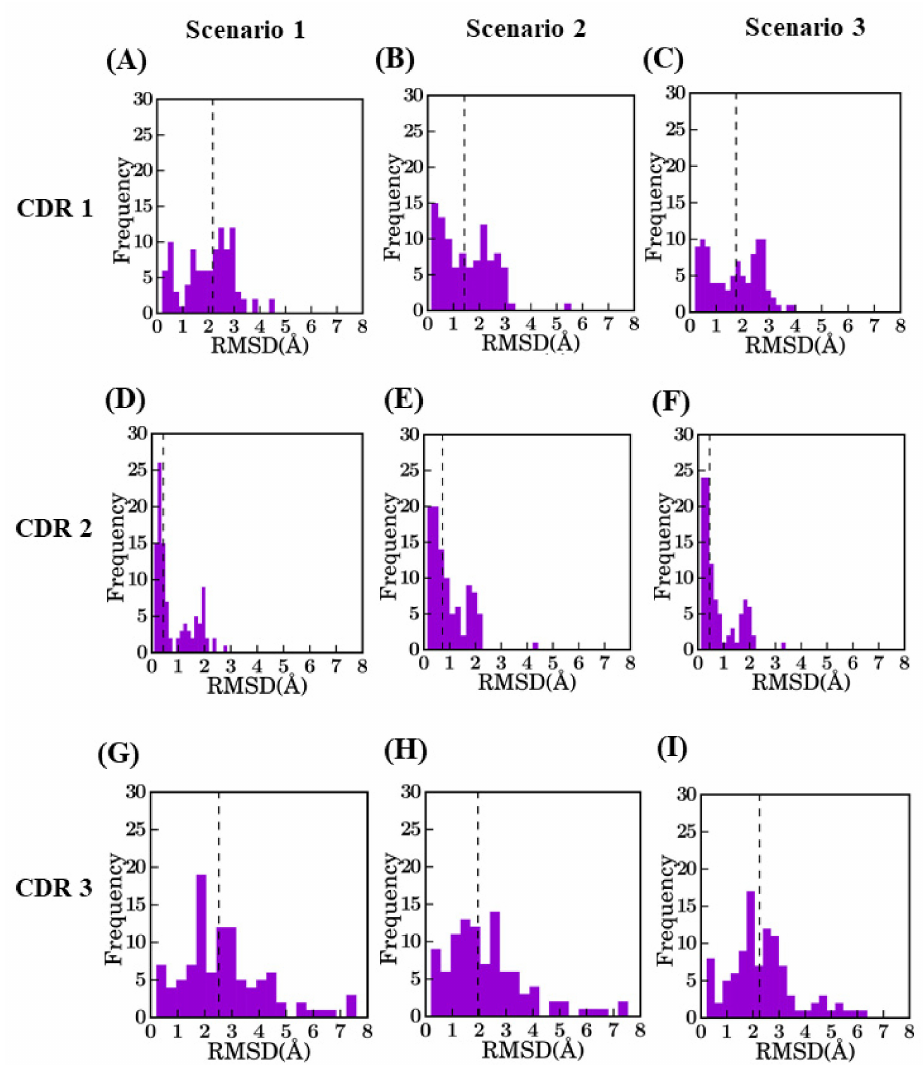
Figure 4. Distribution of RMSD values for different CDRs between selected model and crystal struc- ture. CDR1 for ( A ) bestSeqIdTemp (median value of 2.2 Å), ( B ) bestStructTemp (1.4 Å), and ( C ) 3bestSe- qIdTemp (1.8 Å), CDR2 for ( D ) bestSeqIdTemp (0.4 Å), ( E ) bestStructTemp (0.7 Å), and ( F ) 3bestSeqIdTemp (0.5 Å), CDR3 for ( G ) bestSeqIdTemp (2.5 Å), ( H ) bestStructTemp (1.9 Å), and ( I ) 3bestSeqIdTemp (2.4